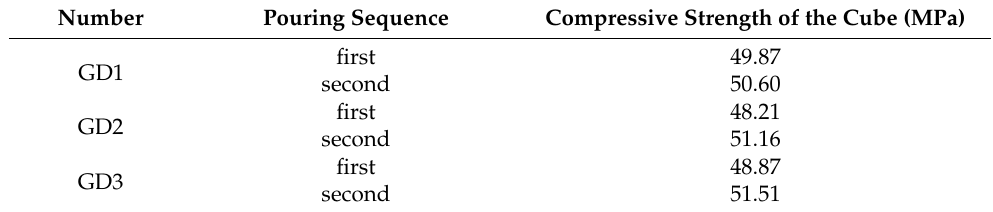
Table 2. Concrete strength test